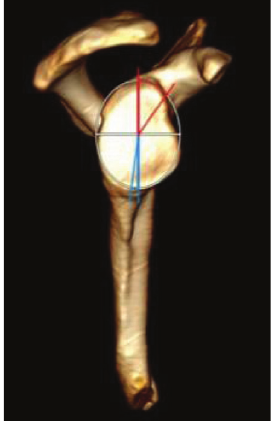
Figure 2. Higher angle (red) and lower angle (blue).